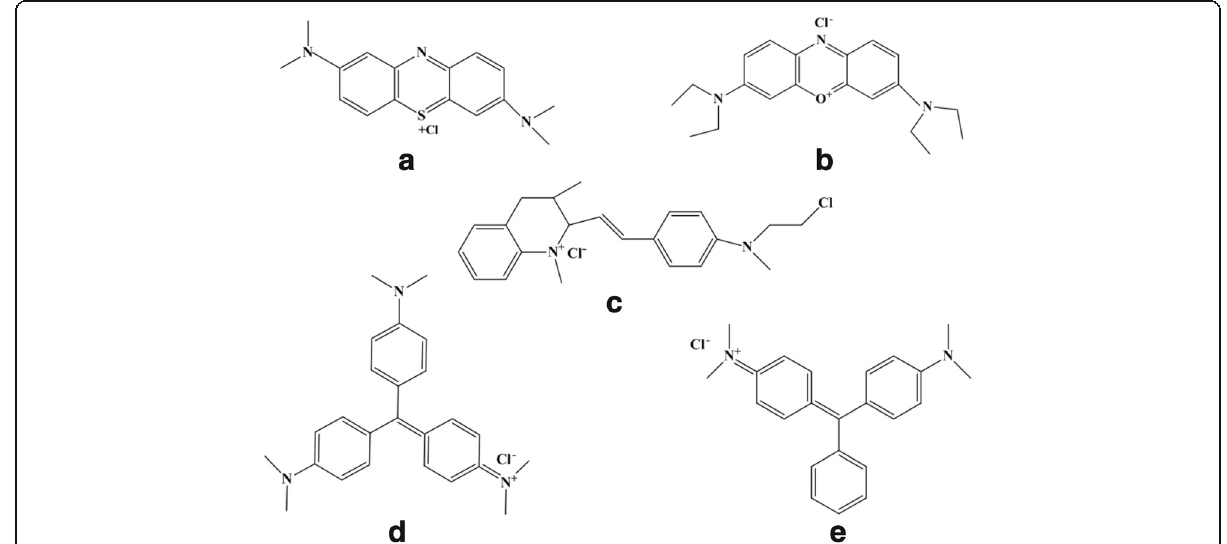
Fig. 1 Molecular structures of ( a ) MB ( b ) GB ( c ) MG ( d ) CV ( e ) FG. As shown as Fig. 1, the structure of five kinds of cationic dyes are